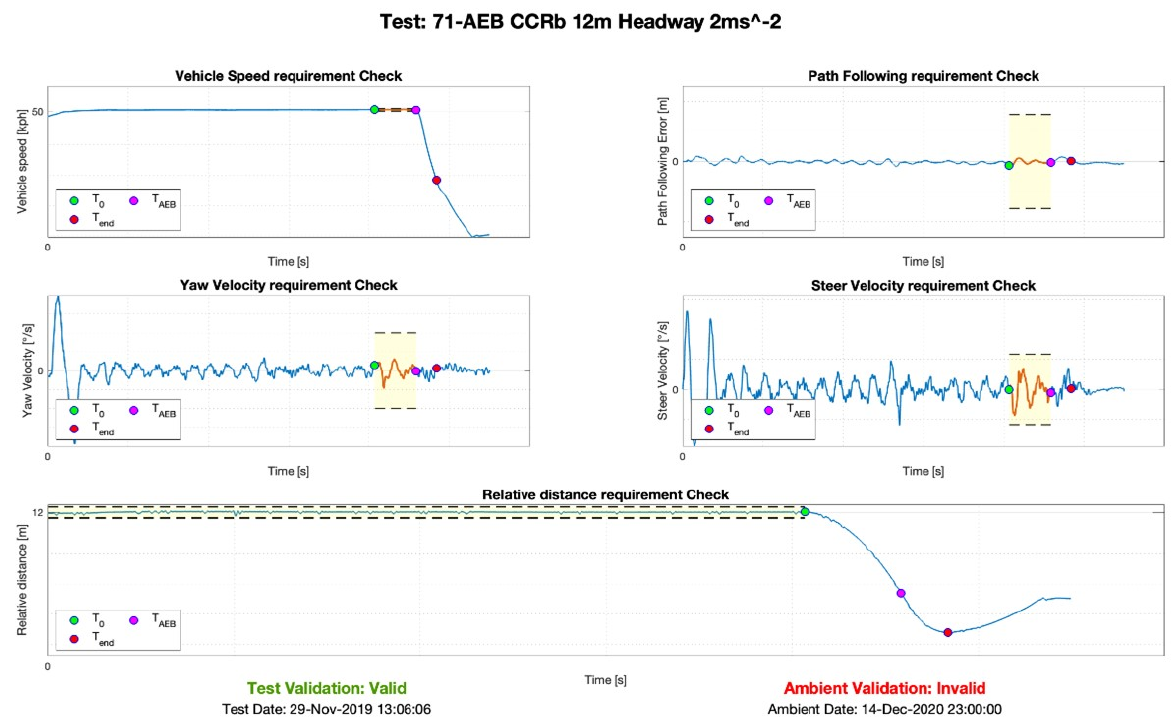
Figure 21. Post-processing results for valid test CCRb.